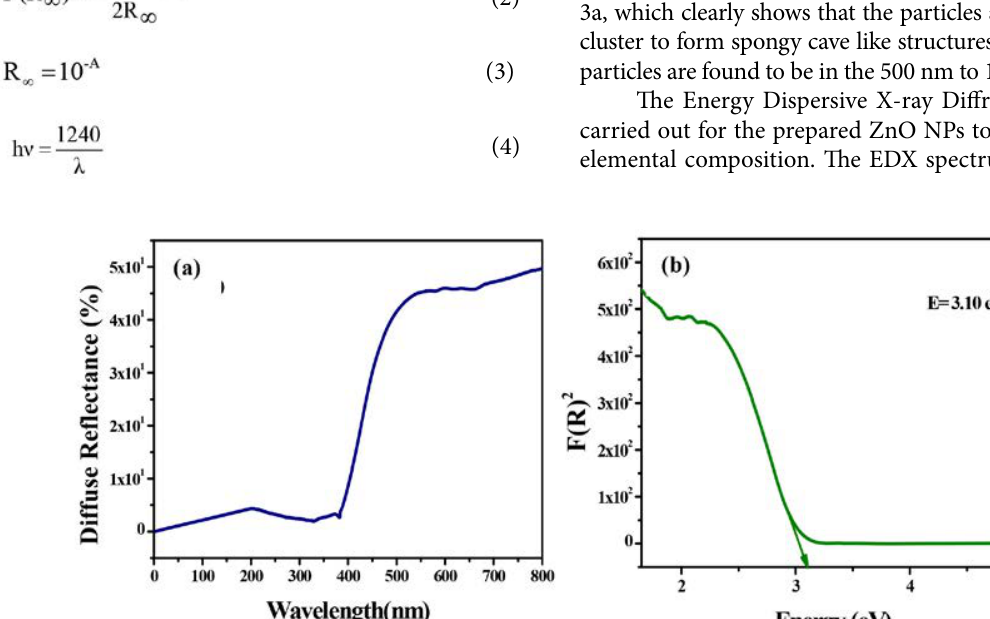
Figure 2. Diffuse reflectance spectrum (a) and direct band gap energy of ZnO (b).